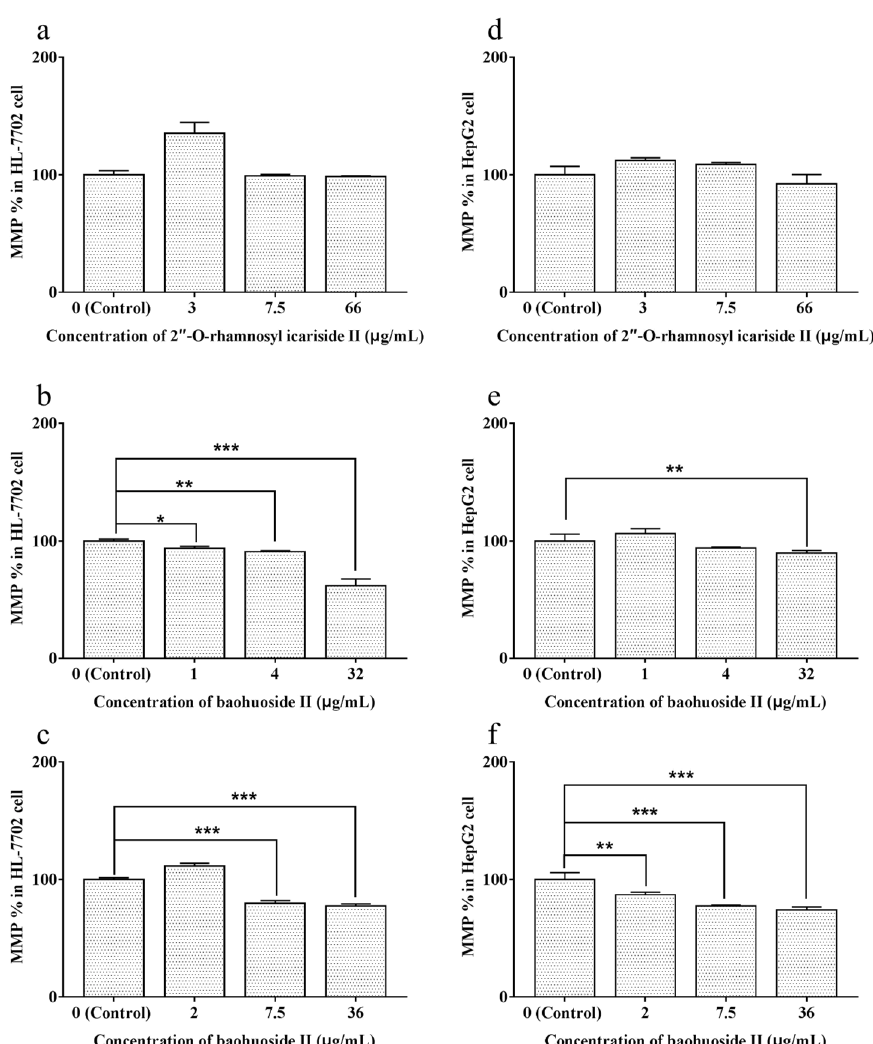
Figure 6. Effects of 2 ″ - O -rhamnosyl icariside II, baohuoside I and baohuoside II on the MMP level in HL-7702 and HepG2 cells at 24 h. Notes: In HL-7702 cells, 2 ″ - O -rhamnosyl icariside II ( a ) at each concentration did not cause a decrease in the MMP level, baohuoside I ( b ) at each concentration caused a significant decrease in the MMP level ( p < 0.05, p < 0.01 and p < 0.005), and baohuoside II ( c ) at 7.5 and 36 μ g/mL caused a significant decrease in the MMP level ( p < 0.005). In HepG2 cells, 2 ″ - O -rhamnosyl icariside II (d) at each concentration also did not cause a decrease in the MMP level, baohuoside I ( e ) at 32 μ g/mL caused a significant decrease in the MMP level ( p < 0.01), and baohuoside II ( f ) at each concentration caused a significant decrease in the MMP level ( p < 0.01, p < 0.005 and p < 0.005). Each value is the mean ± SD of three experiments. * p < 0.05, ** p < 0.01, and *** p < 0.005 compared with the control group (MMP = mitochondrial membrane potential).